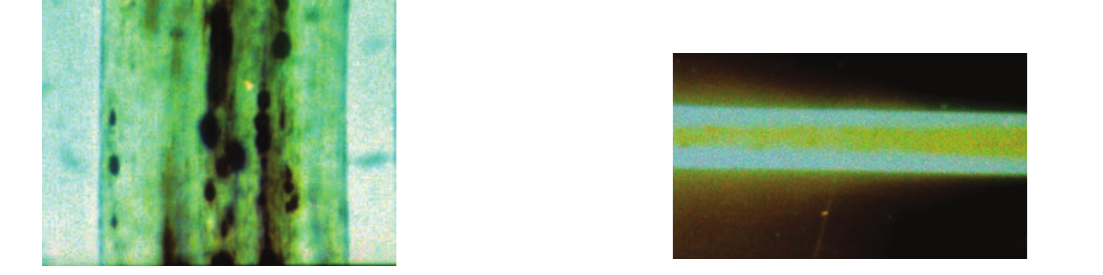
Figure 6 - GPS: hair under polarized light microscopy, whitish hair Figure. 4 - GPS: hair light microscopy (x100). Table 1 - Immunologic data for patients with Chédiak-Higashi syndrome (CHS) or Griscelli-Prunieras syndrome (GPS).